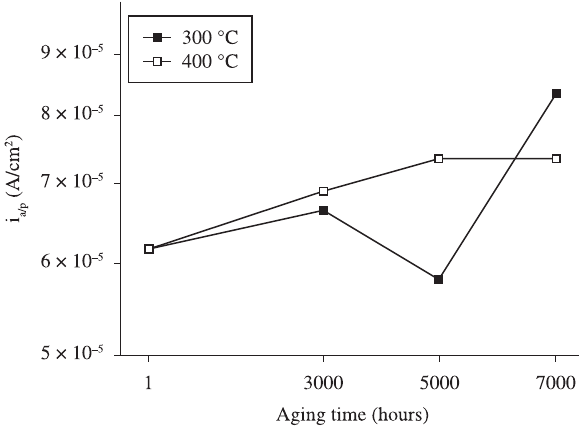
, in the duplex stainless steel aged a/p SO 0.1 M, 2 4